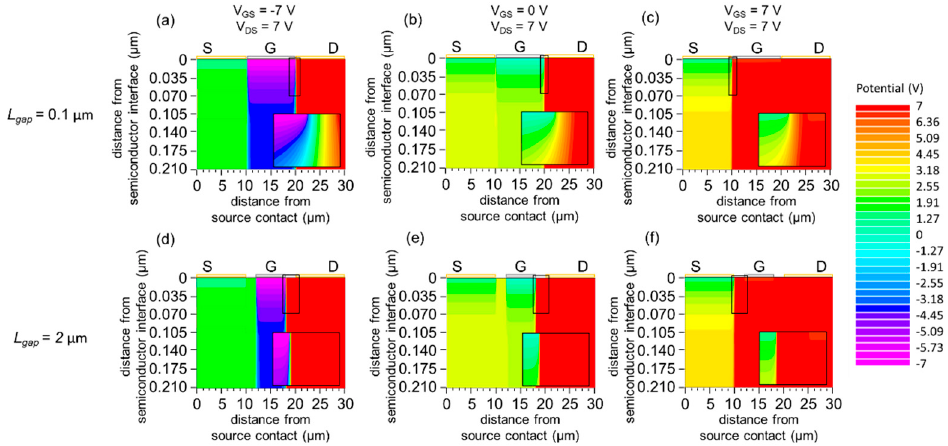
Figure 8. ( a – c ) Simulated potential distribution V ( x , y ) for L gap = 0.1 µ m ( a ) V GS = − 7 V and V DS = 7 V ( I G -dominant regime), ( b ) V GS = 0 V and V DS = 7 V (off regime), ( c ) V GS = 7 V and V DS = 7 V (normal- operation regime). ( d – f ) Simulated potential distribution V ( x , y ) for L gap = 2.0 µ m ( d ) V GS = − 7 V and V DS = 7 V ( I G -dominant regime), ( e ) V GS = 0 V and V DS = 7 V (off regime), ( f ) V GS = 7 V and V DS = 7 V (normal-operation regime). The entire semiconductor layer is shown for all panels ( a – f ). A magnified view of the semiconductor region near the gate electrode (19.8 µm ≤ x ≤ 20.1 µm for ( a , b ), 9.9 µm ≤ x ≤ 10.2 µm for ( c ), 17 µm ≤ x ≤ 21 µm for ( d , e ), 9 µm ≤ x ≤ 13 µm for ( f )) is shown for all panels. The work function of the gate is W G = 5.4 eV.